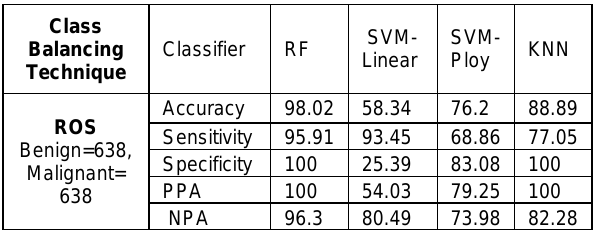
Table 4(c) Result for target Variable Cytology